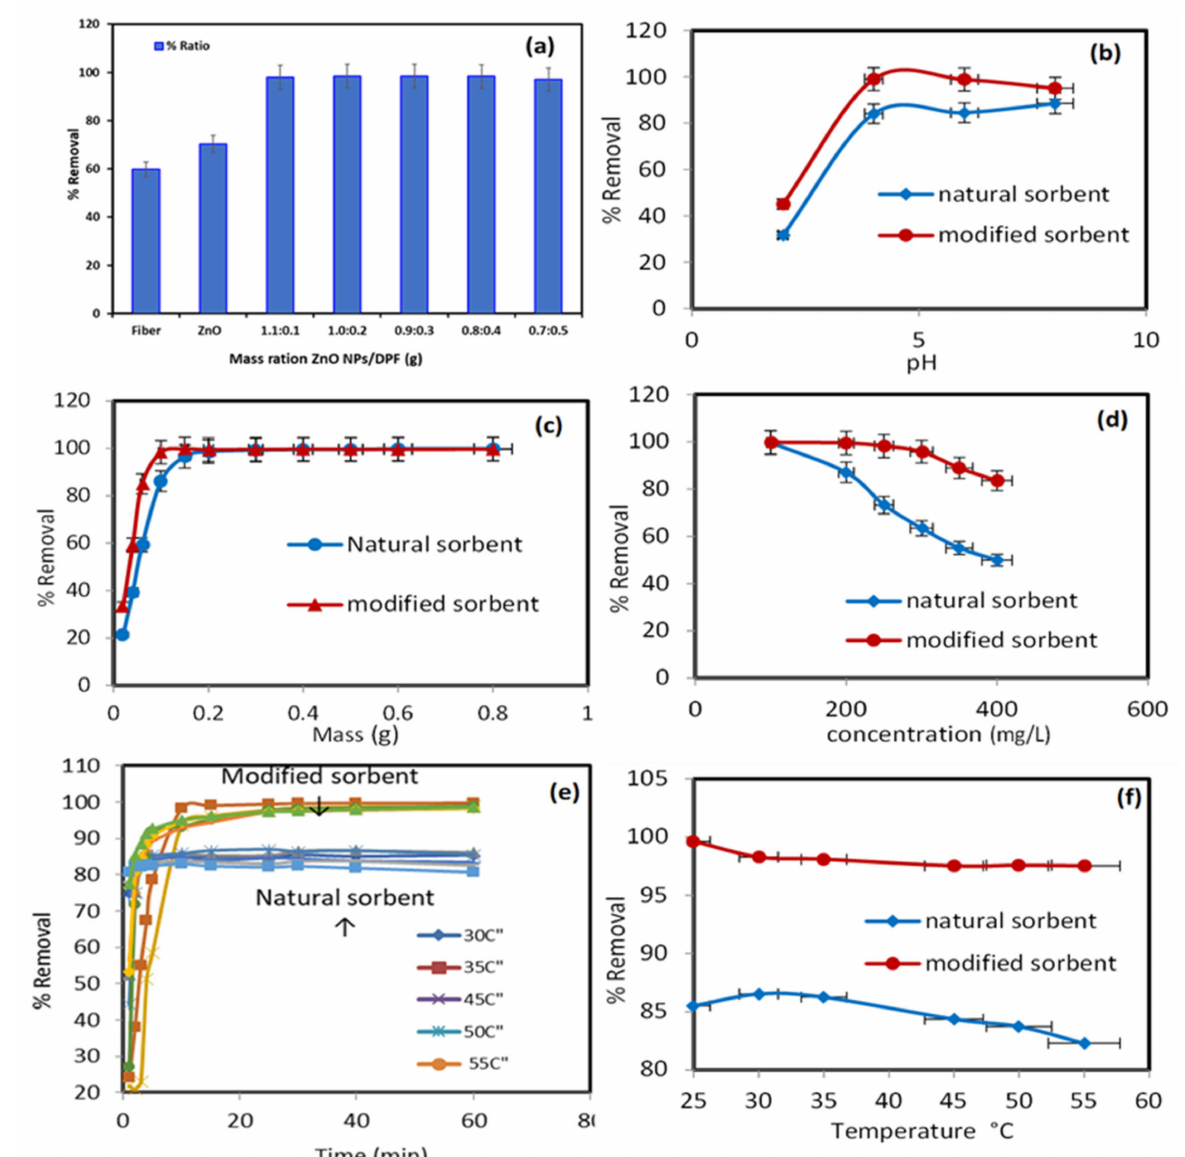
Figure 3. Impact of different parameters on the sorption percentage (%) of Pb 2+ onto the modified sorbent ZnO NP/DPF: modified sorbent ratios ( a ), extraction media pH ( b ), sorbent dose ( c ), solution concentrations ( d ), contact time, and ( e ) and solution temperatures ( f